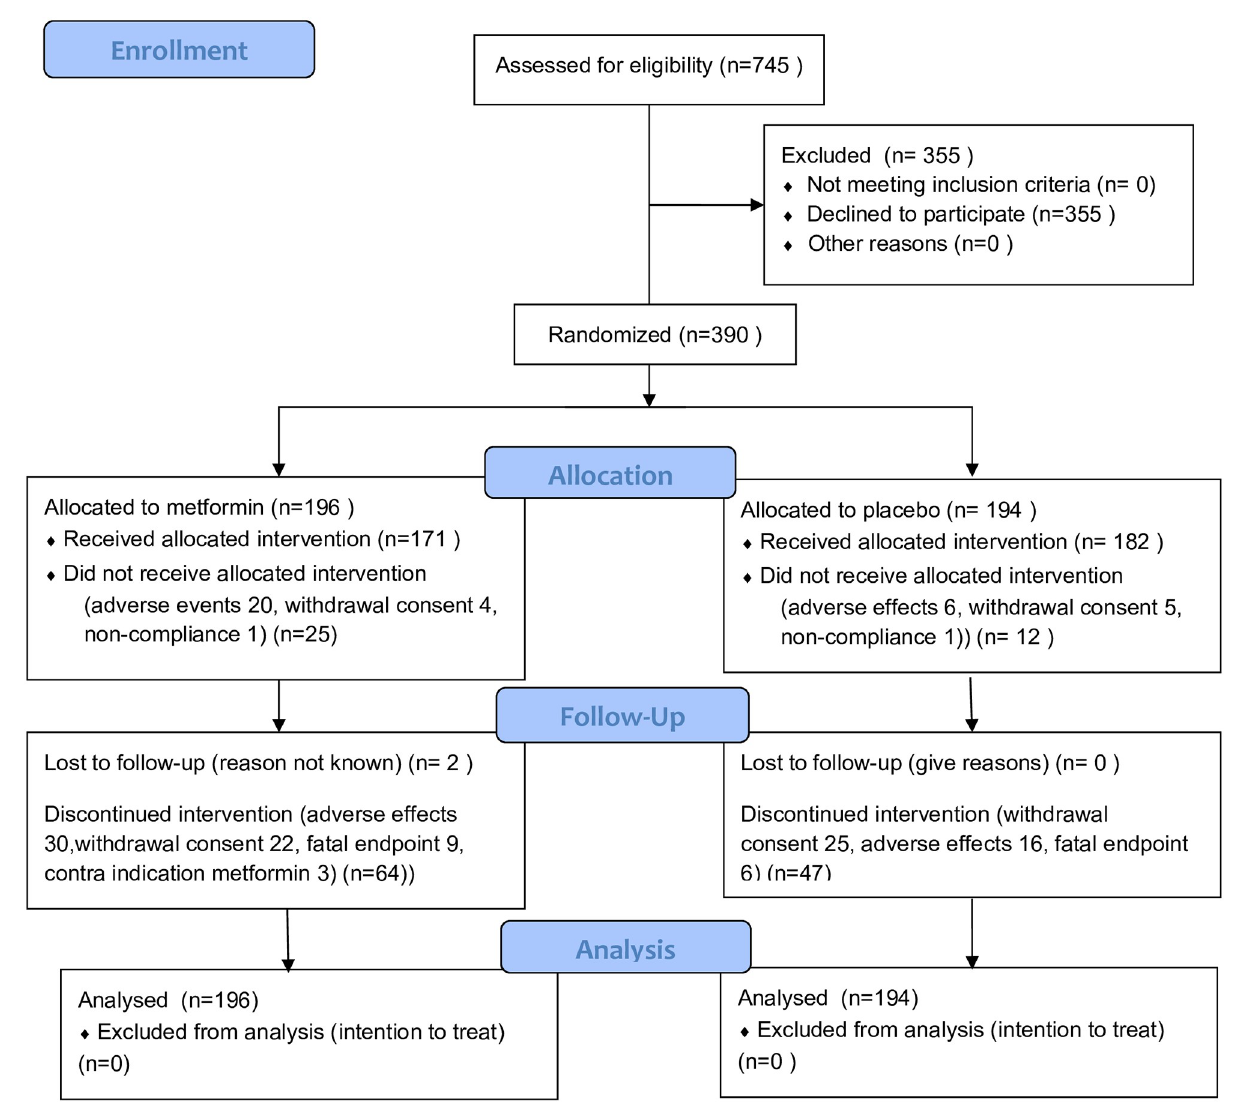
Fig 1. Flowchart. Fixed effects of the model are shown in Table 2. NT-proBNP levels increased slowly over time. The time effect was an increase of 6% (95%CI 3;8, p < 0.001) per year. NT-proBNP signif- icantly and positively correlated with age (increase of 5% [95%CI 4;6, P < 0.001] per year) and prior cardiovascular disease (increase of 29% [95%CI 19–39, P < 0.001] per sum score point). Addition of age and/or prior cardiovascular disease as interaction terms and adjustment for eGFR or body mass index did not change our results either. Also we respecified the correlation structure of our model with autoregressive correlation. The results remained the same (-1% [95%CI -5:3, p = 0.60). In addition we did a per protocol analysis for the patients who completed their final visit. Results remained the same (-1% [95%CI -5:3, p = 0.66).